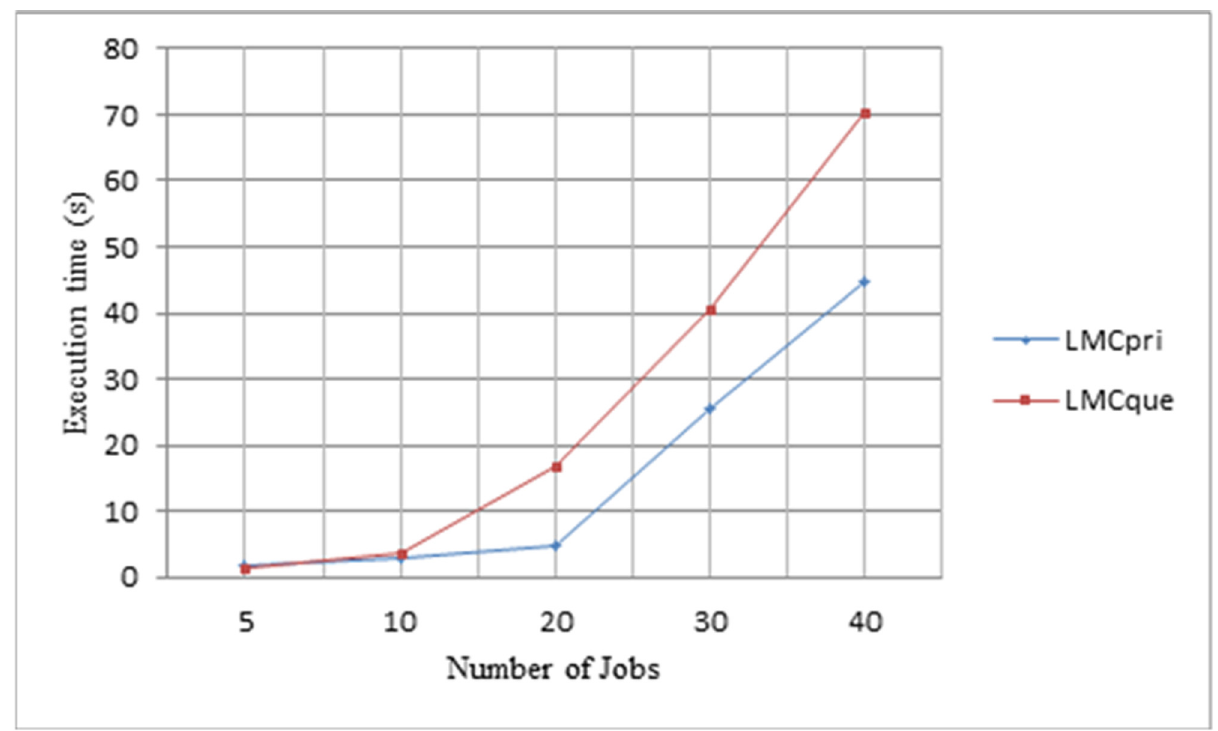
Fig 10. Comparing LMCpri with LMCque at execution time. Different numbers of jobs are displayed in x-axis, and y-axis presents the average execution time of jobs.